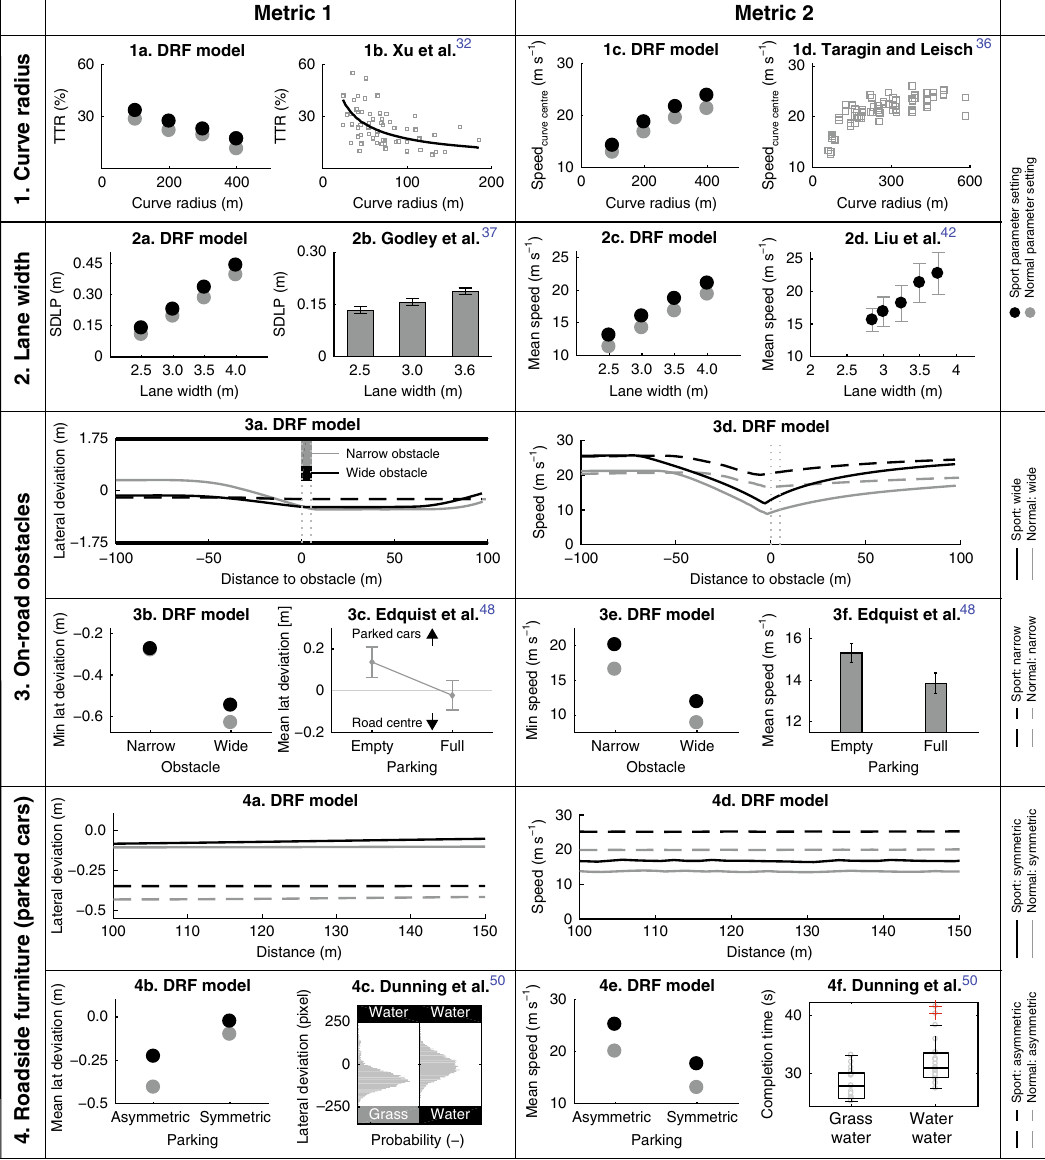
Fig. 4 Validating the model in road scenarios using literature. Each row represents one scenario and the columns compare two different metrics in that scenario. The DRF model results are compared to the results from literature (Supplementary Notes 1 – 8) in the adjacent sub fi gures (Supplementary Figures 3 – 6). In the DRF model sub fi gures, the black and grey markers represent the sport and normal parameter settings, respectively. 1 Curve radius: 1a and 1b show that the DRF model predicts the decrease in ‘ curve-cutting ’ (quanti fi ed using TTR) as curve radius increases. 1c and 1d show the speed at the curve centres. The sport setting of DRF cuts the curves more (1a) and drives at higher speeds (1c) compared to the normal setting. 2 Lane width: 2b shows that the (mean±SE) standard deviation of lateral position (SDLP) of the vehicle increases as the lane width increases. The DRF model (2a) can predict this trend. 2c and 2d (mean± SD) show that the speed at which drivers negotiate a road increases as the lane width increases. 3 On-road obstacles: In 3b, the ‘ wide ’ obstacle encroaches more onto the road compared to the ‘ narrow ’ obstacle. The minimum lateral deviation (3b) is calculated from the trajectories in 3a. Drivers moved away from the parked cars (3c: lane centre = 0, bars indicate 95% CIs). 3b shows that the DRF model showed a similar trend of moving away from the obstacle. Drivers drove slower when there were parked cars, as compared to when there were no parked cars encroaching the road (3f: bars indicate 95% CIs). 3e shows that the DRF model slows down for obstacles covering the road partially. 4 Roadside furniture: In the asymmetric case, the mean lateral deviation from the lane centre is away from the parked cars (4b) and away from water (more dangerous than grass) in 4c. Sub fi gure 4c shows the distribution of lateral position of the participants. 4e and 4f show that in the symmetric condition with ‘ danger ’ on both sides of the lane, the DRF model correctly predicted that the drivers drove slower than in the asymmetric case. The mean lateral deviation (4b) and mean speed (4e) are calculated from the trajectories in 4a and 4d,